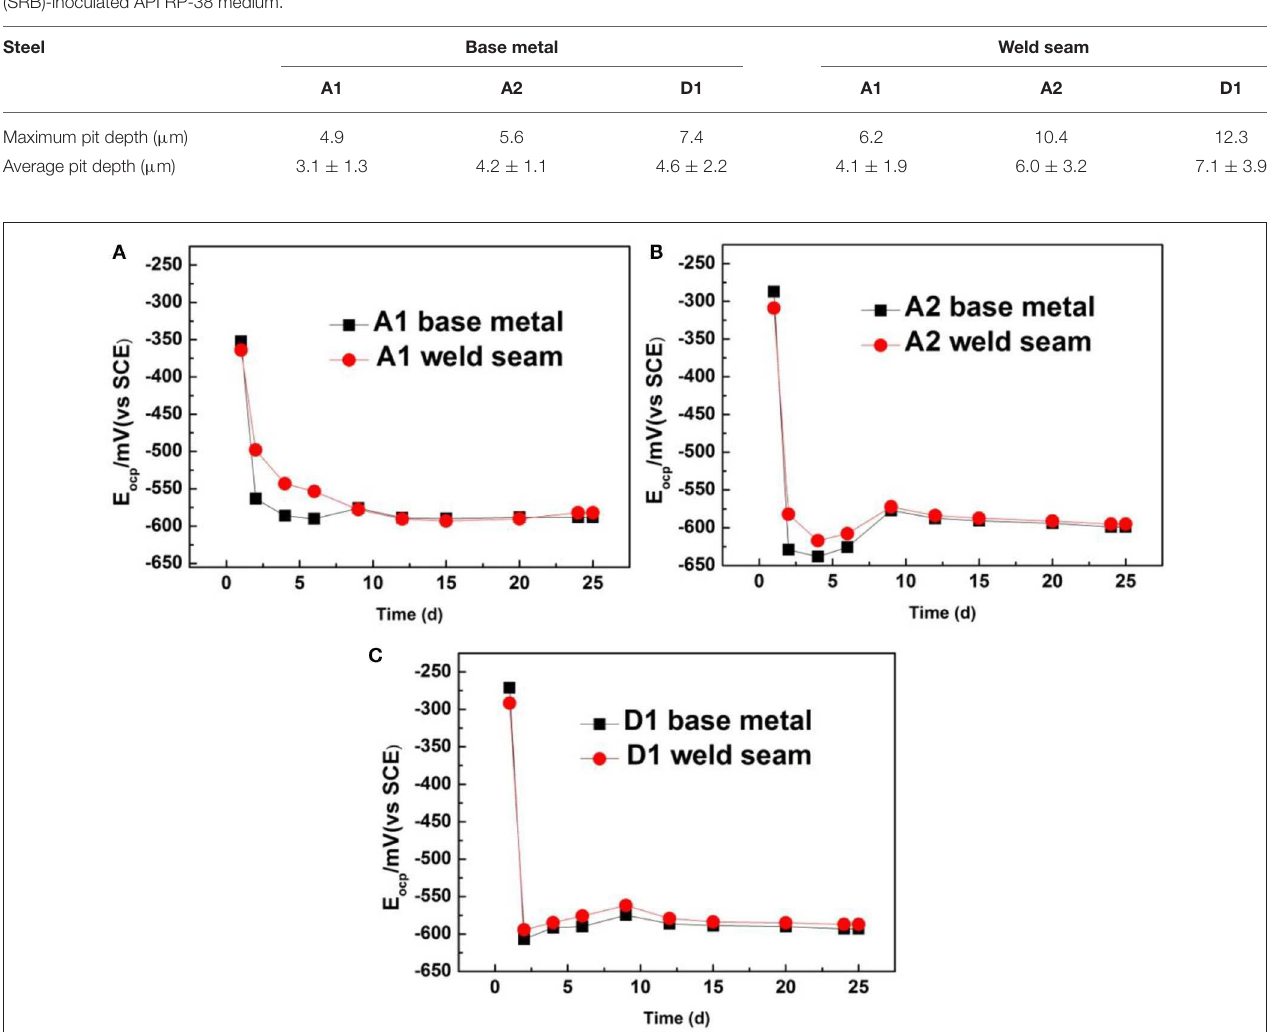
TABLE 2 | Pit depths (measured from 30 pits for each) of the base metal and weld seam of three stainless steels after 25 days exposure in sulfate-reducing bacteria (SRB)-inoculated API RP-38 medium.